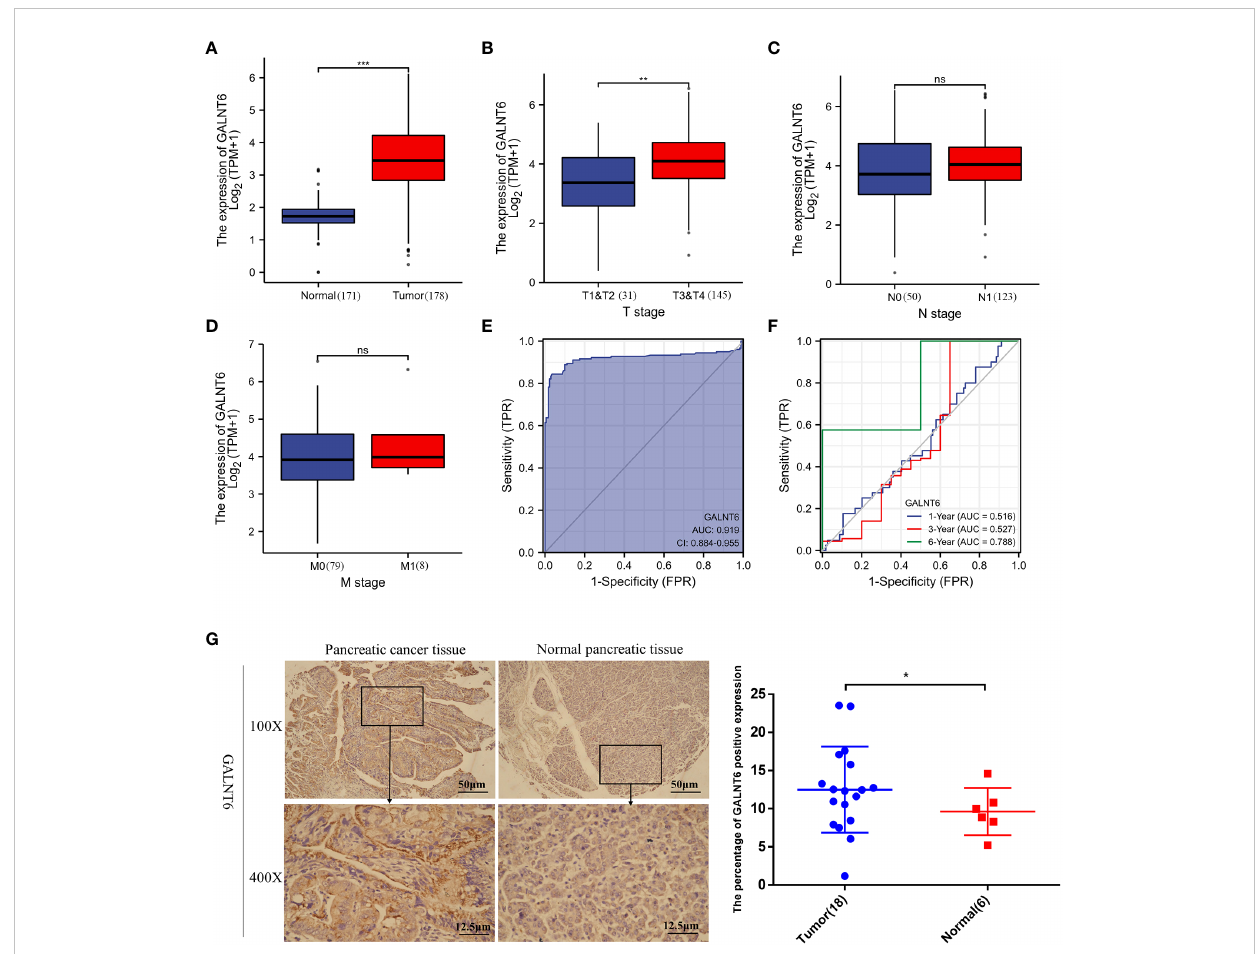
FIGURE 1 Analysis of GALNT6 in clinical database of pancreatic cancer patients. (A – D) Boxplots showed the expression of GALNT6 in pancreatic cancer and tumor TNM stages. (E, F) ROC and Time-dependent ROC curve showed more sensitive diagnosis of GALNT6 in pancreatic cancer (AUC=0.919). (G) Representative images of IHC. IHC was applied to detect the expression of GALNT6 in 18 pancreatic cancer tissues and 6 pancreatic normal tissues. ns, p >0.05; *p <0.05; **p <0.01; ***p